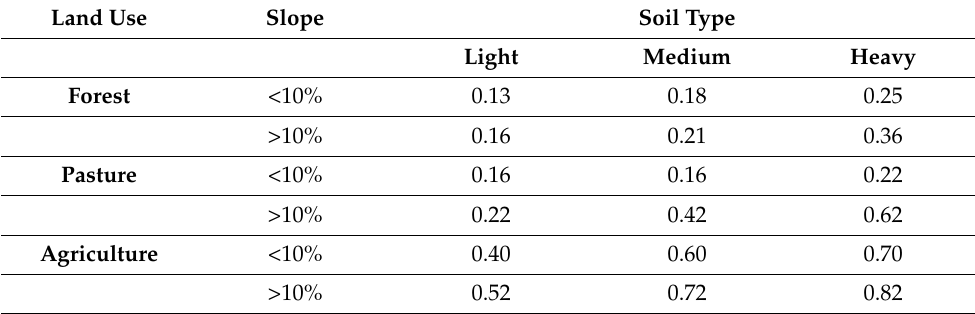
Figure 5. Water discharge maps for simulations with precipitation values of ( A ) 5 mm/h, ( B ) 50 mm/h, and ( C ) 180 mm/h. ( D ) Legend of the water discharge for each simulation. Values in scientific notation for high variability. Map Scale 1:10,000. Table 2. Runoff coefficients adopted for the water discharge analyses